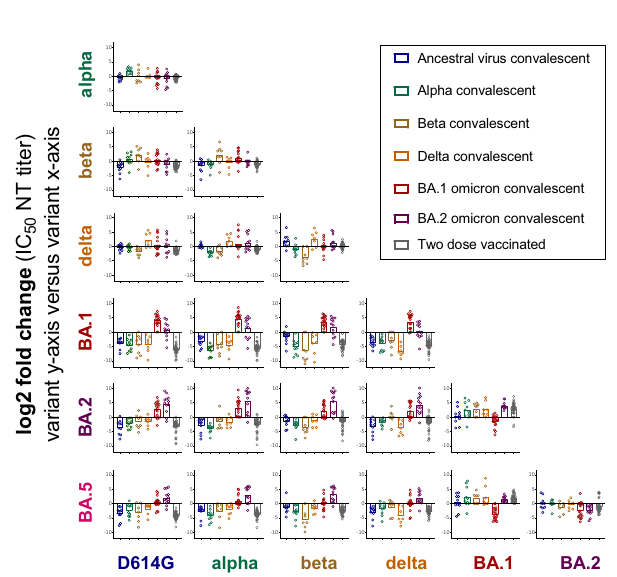
Fig. 1 | BA.2 and BA.5 omicron have a neutralization pro fi le distinct from both pre-omicron variants and BA.1 omicron. Plasma samples were collected after a BA.2 omicron ( n =12, Panel a ) or wild-type infection ( n =10, Panel b ) in previously naïve patients (no vaccination and no known history of prior infection) or in patients with hybrid immunity, Panel c two doses of ChAdOx-S1 (AZ/AZ) followed by delta infection ( n =6) and Panel d two doses of BNT162b2 (BNT/BNT) followed by pre-omicron variant (presumably delta) infection ( n =22). Samples were ana- lyzed for 50 % neutralizing antibody titers (IC 50 ) against D614G (blue), alpha (dark green), alpha + E484K (light green), beta (ocher), gamma (purple), delta (orange), BA.1 (red), BA.2 (violet), and BA.5 (pink) omicron. Shown are individual patient samplesascircles connected bylinesand meantiters asbars. Numbersabove bars indicate proportion of positive samples (titers>1:16). IC 50 titers against BA.2 omi- cron (Panel e ; violet) and BA.5 omicron (Panel f ; pink) for different groups of individuals with single exposure (non-vaccinated convalescent: ancestral virus conv. n =10;alphaconv. n =10;betaconv. n =9;deltaconv. n =7;BA.1conv. n =18;